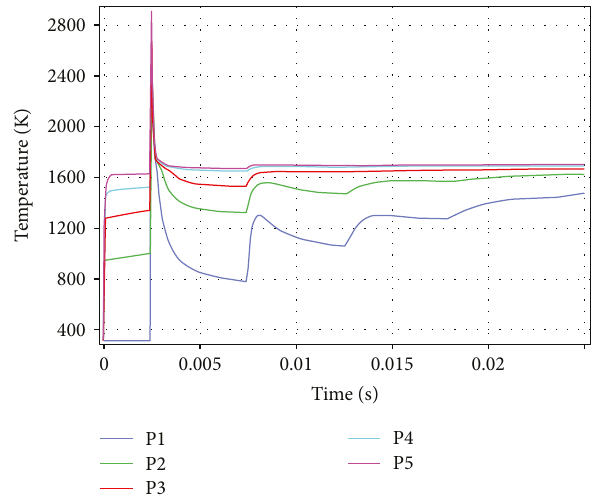
Figure 13: Temperature variation curves of the center points of fi rst scanning track in each layer.